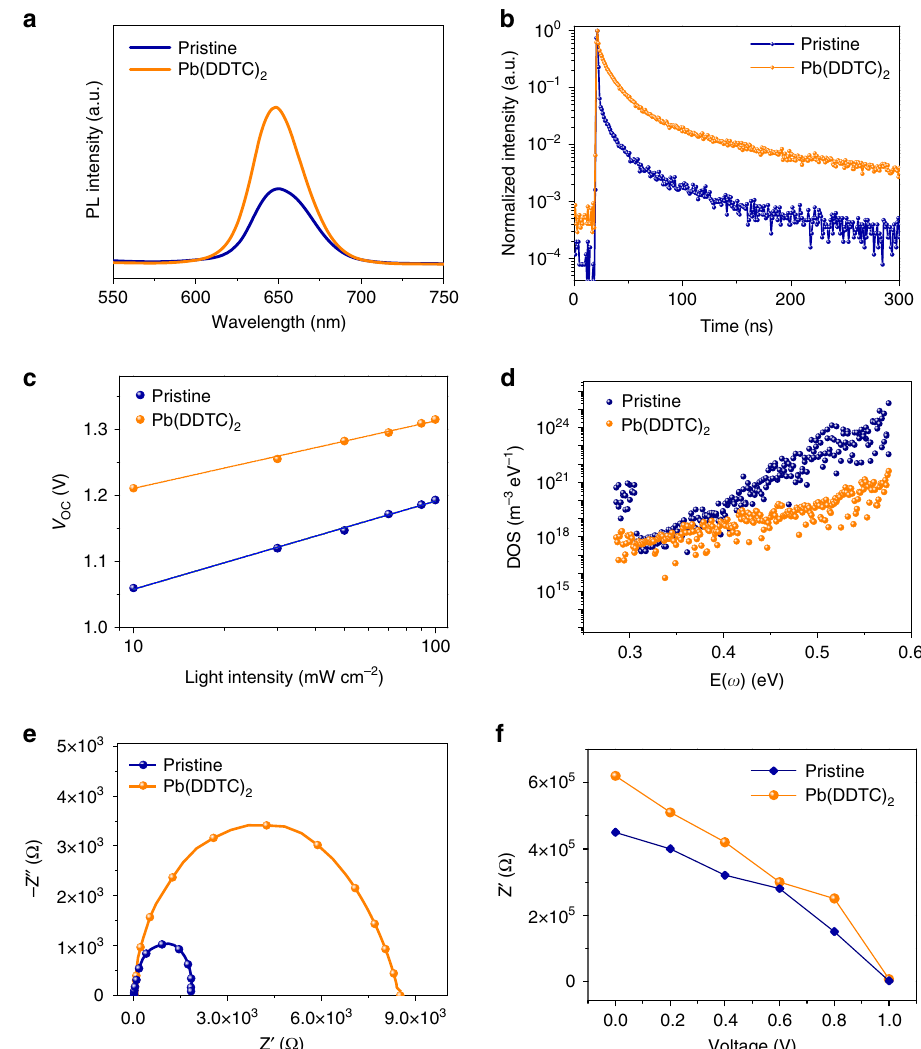
Fig. 3 Performance characterizations of CsPbI 2 Br fi lms and solar cells. a , b Steady-state PL and TRPL spectra, respectively, of the pristine (blue) and chelated (orange) CsPbI 2 Br fi lm deposited on glass substrate. c Plots of light intensity dependent V OC of the pristine (blue) and chelated (orange) CsPbI 2 Br devices. d tDOS of the pristine (blue) and chelated (orange) CsPbI 2 Br devices extracted from thermal admittance spectroscopy. e Nyquist plots of the pristine (blue) and chelated (orange) CsPbI 2 Br devices under dark with a bias voltage of 1.0 V. f Dependence of R rec on applied bias voltage for pristine (blue) and chelated (orange) CsPbI 2 Br device. R rec was obtained by fi tting the EIS spectra at